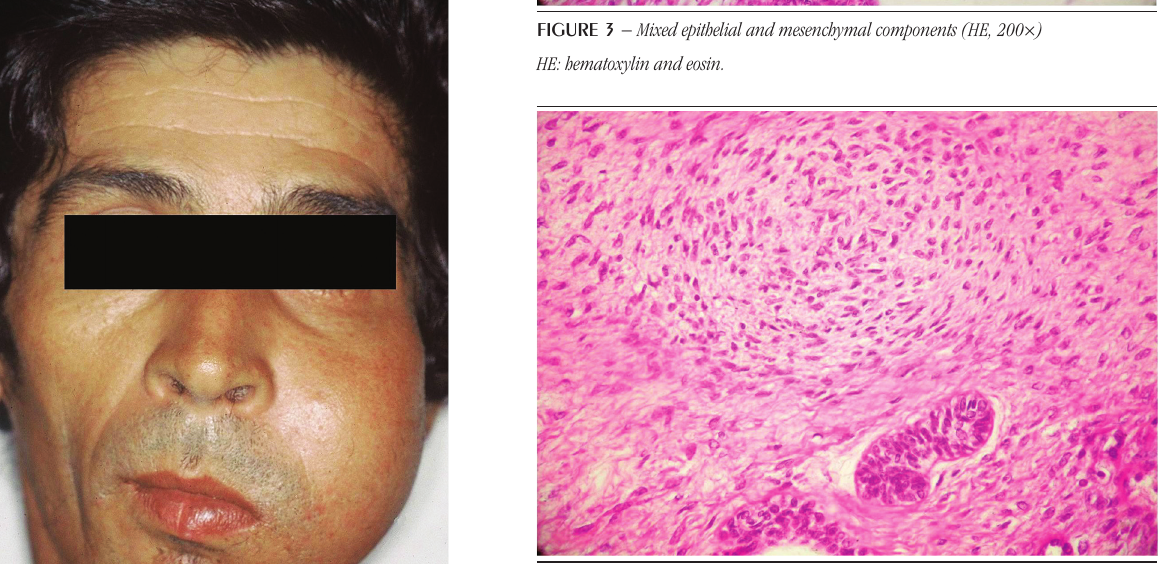
figurE 4 − High cellularity with mild cellular pleomorphism (HE, 200×) HE: hematoxylin and eosin.